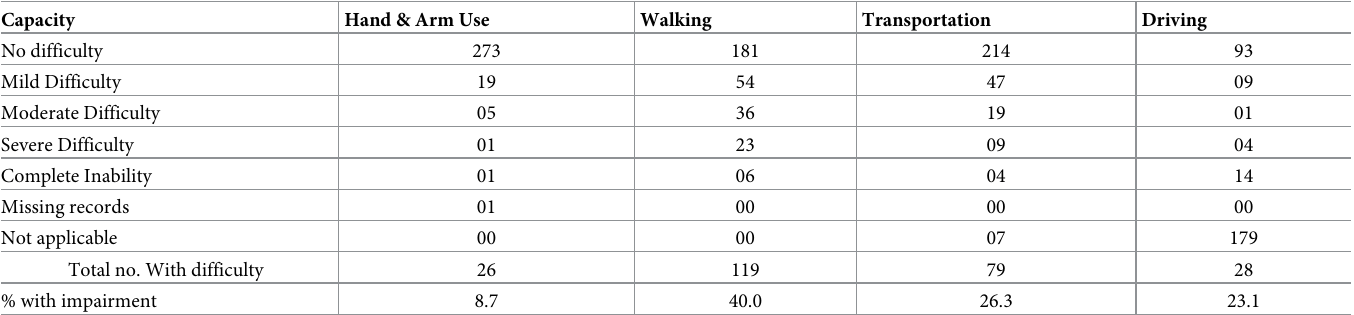
Table 4. Difficulties in